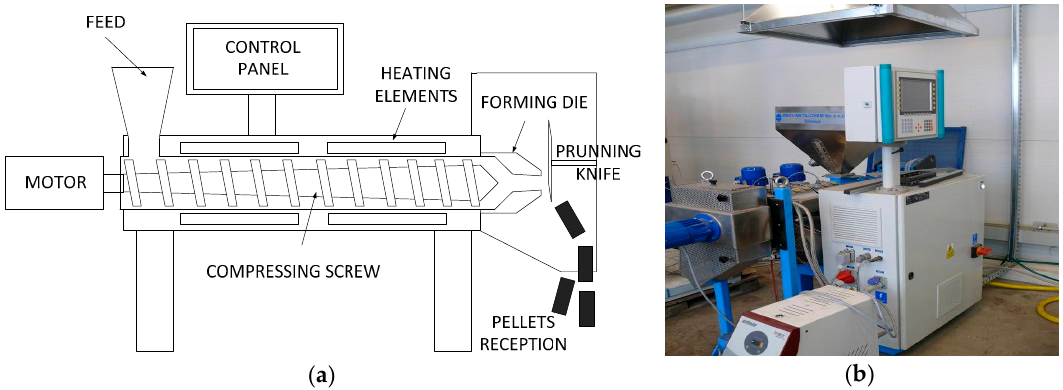
Figure 2. ( a ) Scheme of the single-screw extruder; ( b ) general view of the single-screw